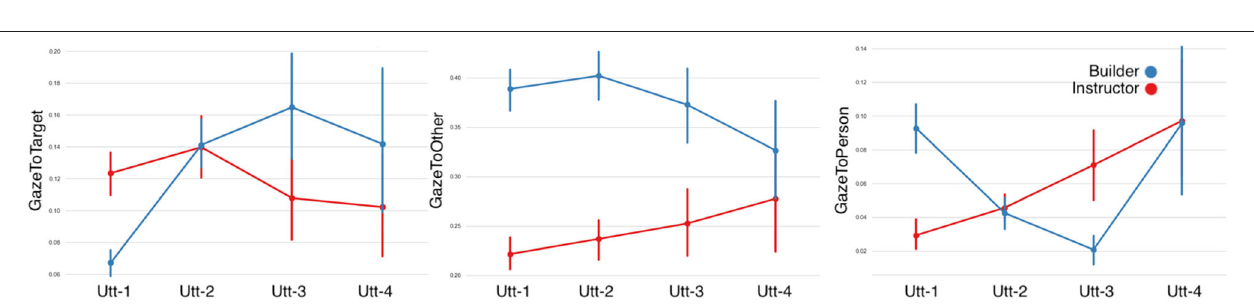
r = –0.21, p < 0.001), indicating a decrease in cognitive load for builders as more fragments are spoken by instructors.